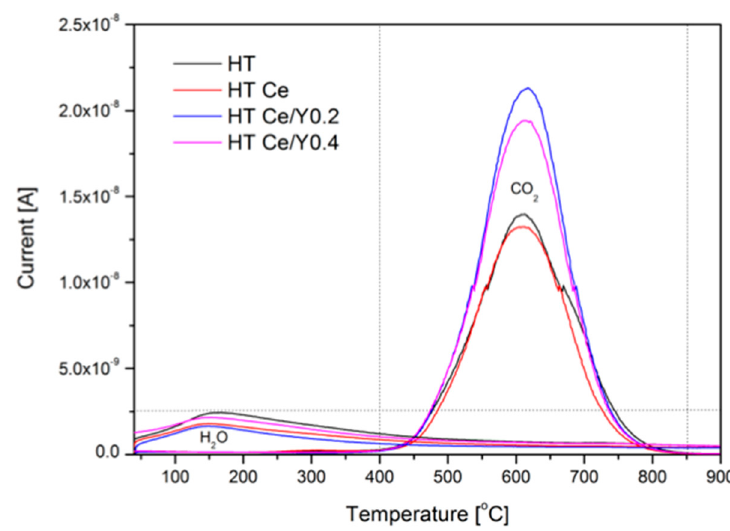
Figure 9. Mass spectrometry (MS) signals of water vapor and carbon dioxide during thermal decomposition of the spent catalysts.